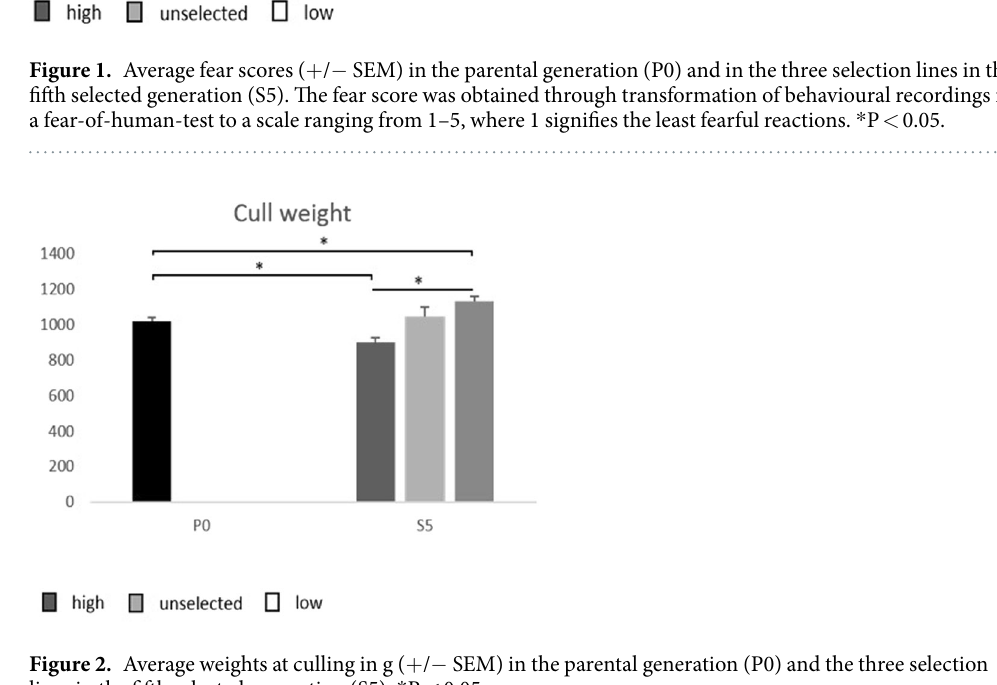
Figure 2. Average weights at culling in g ( + / − SEM) in the parental generation (P0) and the three selection lines in the fifth selected generation (S5). * P <